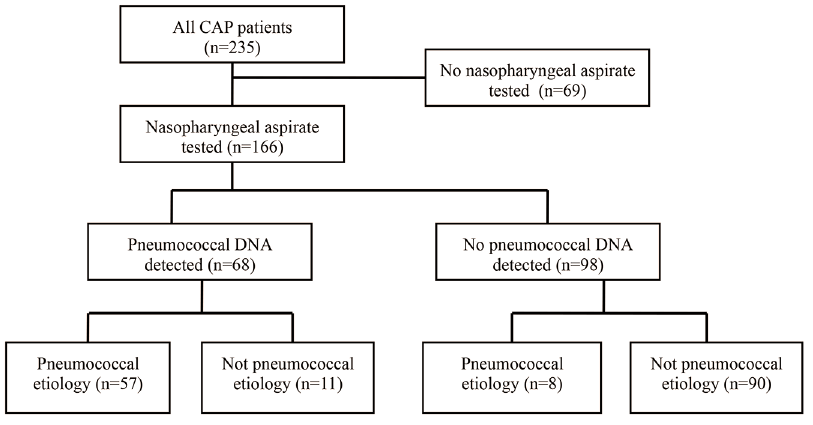
Fig 1. Flow chart of the study population with and without nasopharyngeal aspirate tested with PCR for pneumococcal DNA.